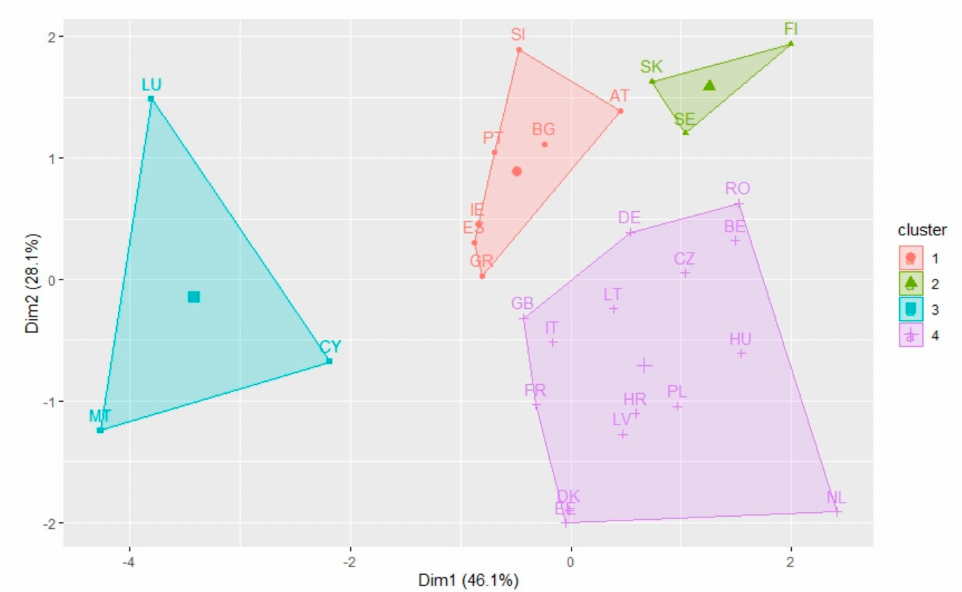
Figure 12. The results of k-means clustering after principal component analysis (PCA). Dim1 refers to first principal component, Dim2 refers to second principal component. Source: own